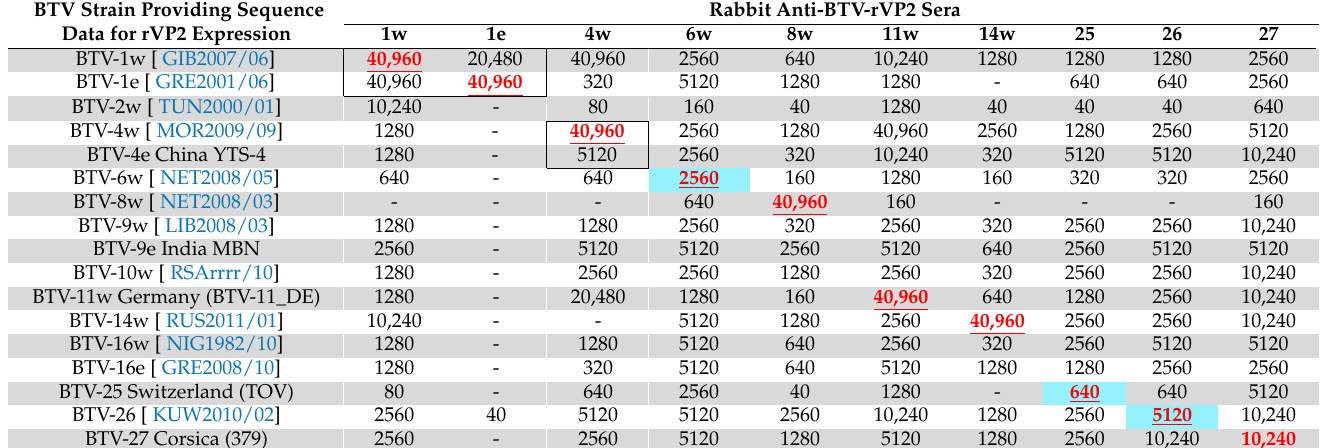
Table 2. I-ELISA titres for rabbit anti-BTV-rVP2 sera tested against BTV rVP2 proteins. BTV Strain Providing Sequence Data for rVP2